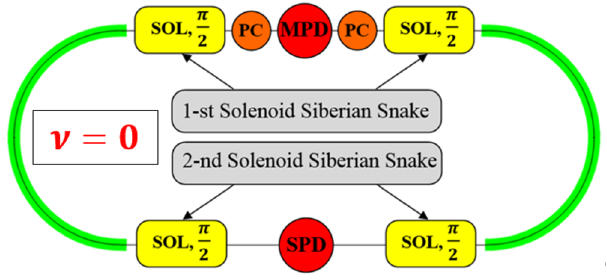
Figure 4. Polarization control in the NICA collider with two solenoid snakes (the ST mode over the total energy range)